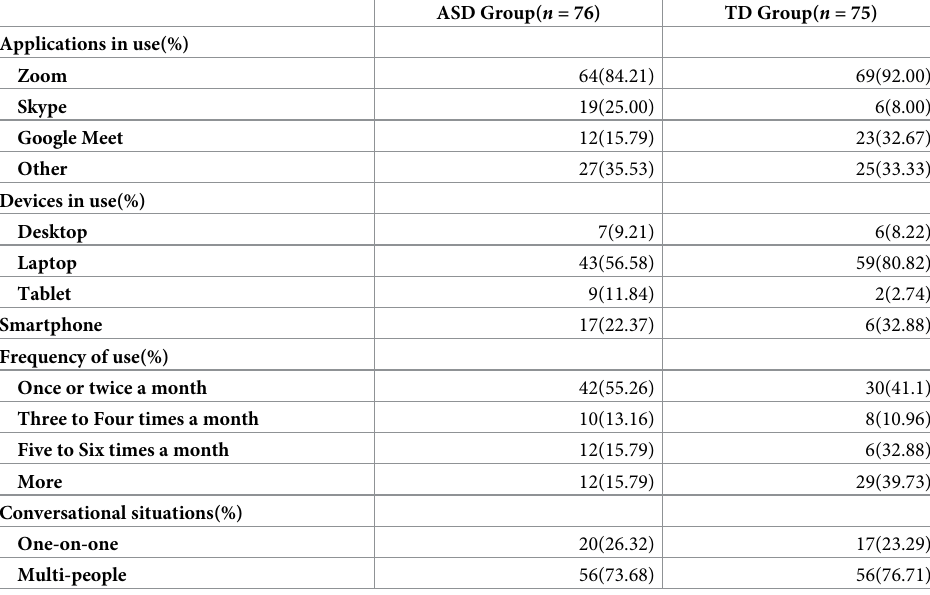
Table 2. Use of video calling in the ASD and TD